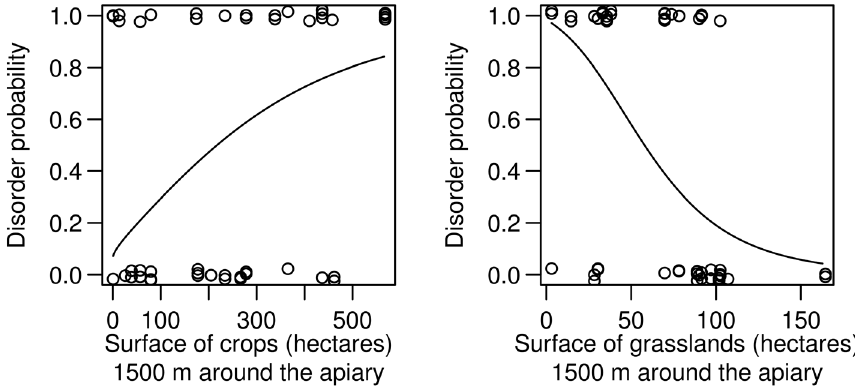
Figure 8. Probability of honeybee colony disorders depending on the apiary’s environment. Consideration of crop surface vs. grassland surface in a radius of 1500 m around the apiary. Crops include fruit, vegetables, fodder production and horticulture. For each graph, the value of the variable not displayed is fixed to its observed mean (n=53 colonies). doi:10.1371/journal.pone.0103073.g008 PLOS ONE |